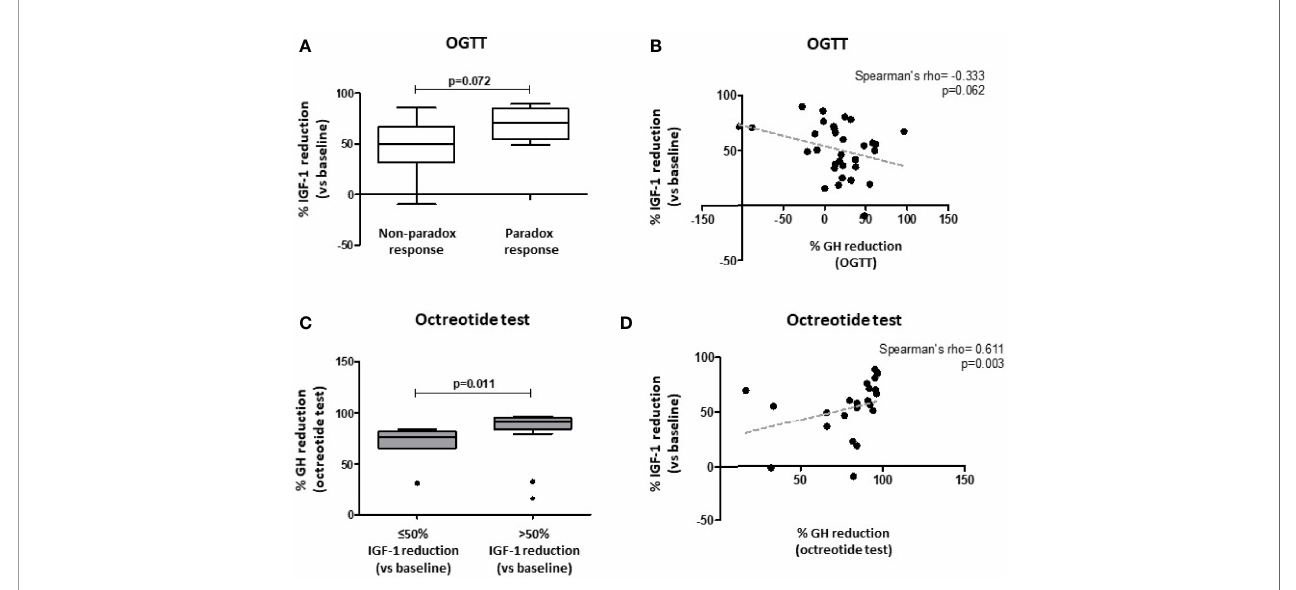
FIGURE 4 | Biochemical response after fi rst-line SRL treatment (6 months) with respect to patients ’ response to both oral glucose tolerance test (OGTT) and acute octreotide test. Patients with a paradoxical increase of GH levels during OGTT ( ≥ 20% GH increase vs. baseline) showed a trend towards a higher % IGF-1 reduction after fg-SRL treatment, compared with the non-paradoxical group (A) . A trend for an inverse correlation between the % GH reduction after OGTT (nadir vs. baseline) and the % IGF-1 reduction after 6-month SRL treatment was observed (B) . Patients with higher % GH reduction after acute octreotide test (nadir vs. baseline) were more likely to reach a >50% IGF-1 reduction, compared to those with a lower response rate (C) . The % GH reduction after acute octreotide test was directly correlated with the % IGF-1 reduction after 6-month SRL therapy (D) . OGTT, oral glucose tolerance test; fg-SRLs, fi rst-generation somatostatin receptor